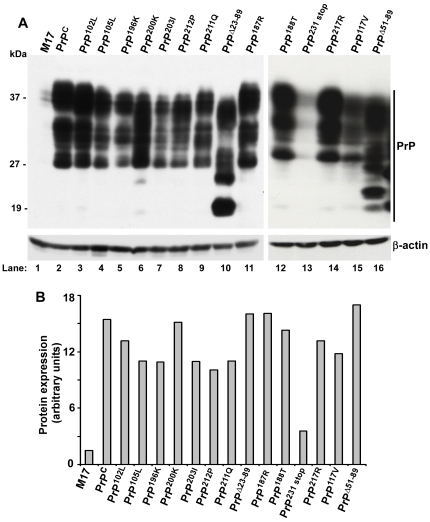
Cytoprotective effect of PrP is independent of its expression level.(A) Equal amount of protein from lysates of M17, PrPC, PrP102L, PrP105L, PrP196K, PrP200K, PrP203I, PrP212P, PrP211Q, PrPΔ23–89, PrP187R, PrP188T, PrP231stop, PrP217R, PrP117V, and PrPΔ51–89 was subjected to Western blotting. Probing for PrP shows the expected glycoforms of PrP in all cell lines (lanes 1–16). Re-probing for β-actin shows equal loading of protein. (B) Quantification after normalization with β-actin shows 6–10 fold higher expression of PrPC and mutant cell lines relative to M17 cells. The only exception are PrP231stop-cells that express 1.8 fold higher levels of PrPC compared to M17 cells. Quantitative analysis of one representative experiment is shown.